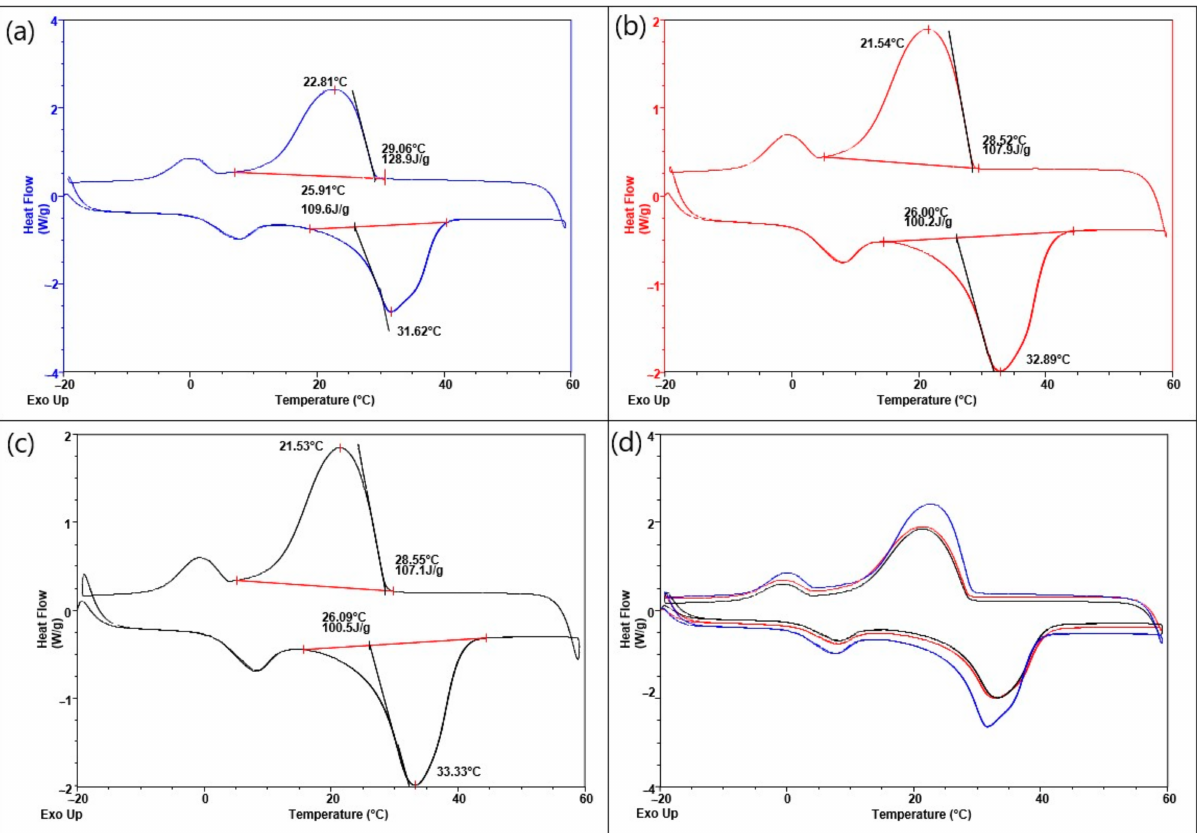
Figure 5. DSC thermograms of the microcapsules MPCM32D: unmodified ( a ), with 5 wt.% MWCNTs ( b ) and 5 wt.% PEDOT: PSS ( c ) shell-modified, and their summed thermogram ( d